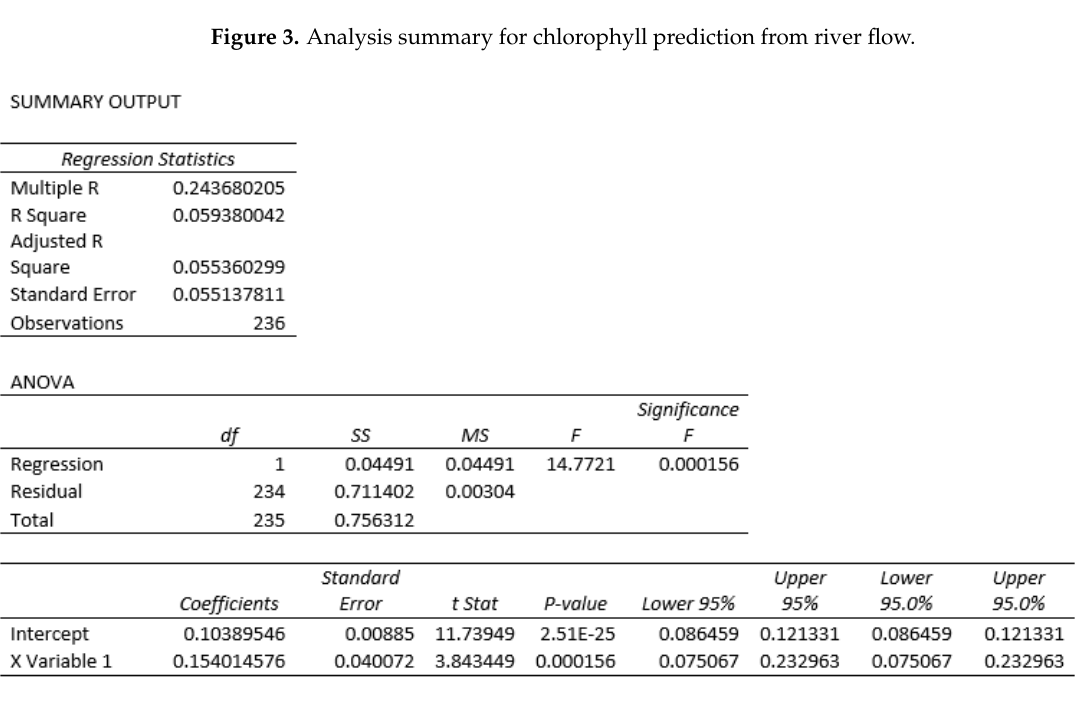
Figure 4. Analysis summary for chlorophyll prediction from AOD.